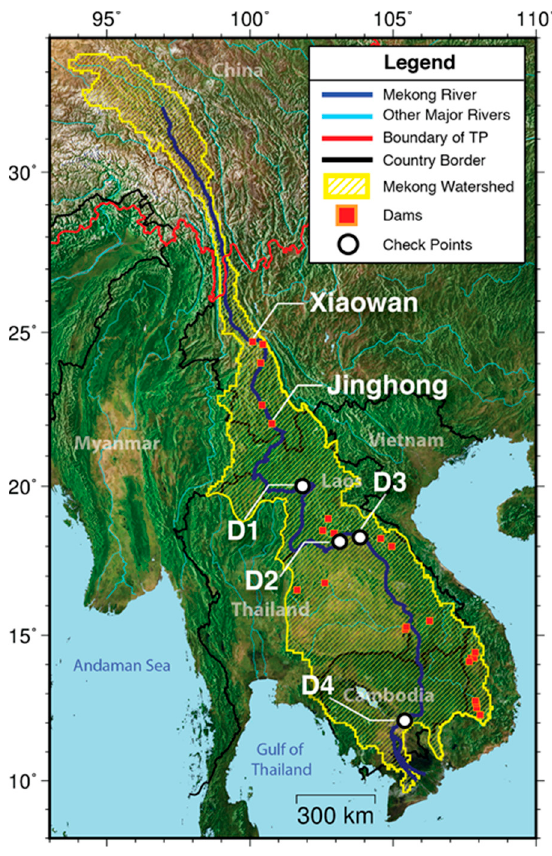
Figure 2. Location map of the Mekong River and study area. Combined altimetry and Landsat imageries to derive WL are performed at Xiaowan and Jinghong Dams. Four checkpoints (D1–D4) are used to inspect the change of river flow after dam constructions. D1–D3 have both Envisat and Jason-2 crossovers nearby, while D4 has only Jason-2.